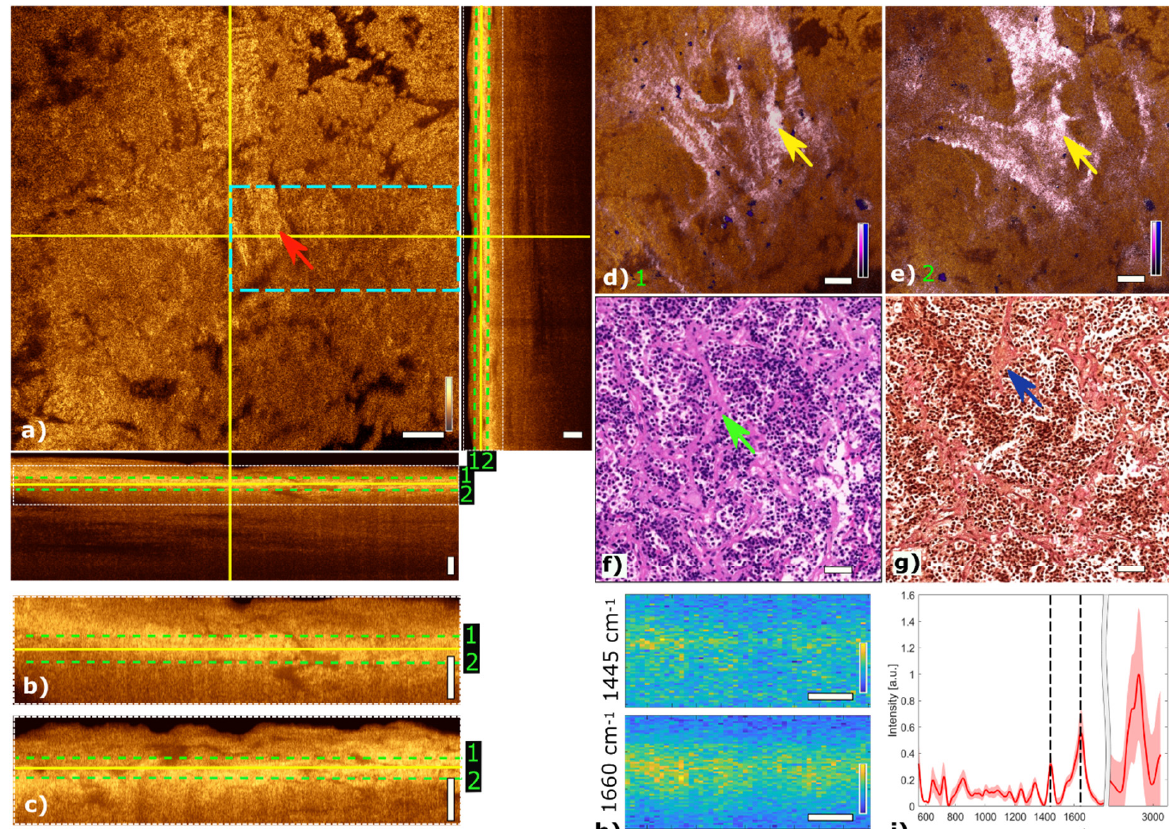
Figure 5. Multimodal investigation of a representative gonadotroph adenoma. ( a ) OCT orthogonal view: en face image shows the plane at the depth indicated in B-scans (depth profiles) with yellow lines. OCT en face and B-scans were averaged 5 times. Red arrow indicates connective tissue. The green dashed lines (1 and 2) in the OCT B-scans indicate the position